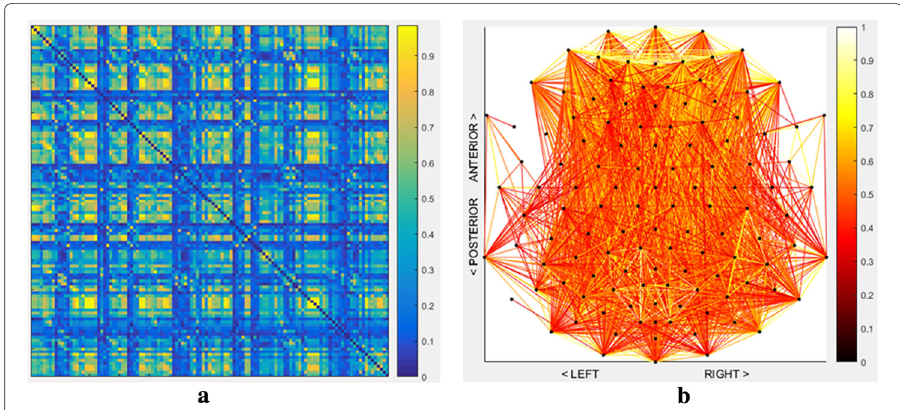
Fig. 1 Convention types of EEG coherence network visualization techniques. a Matrix Representation. b Node-link